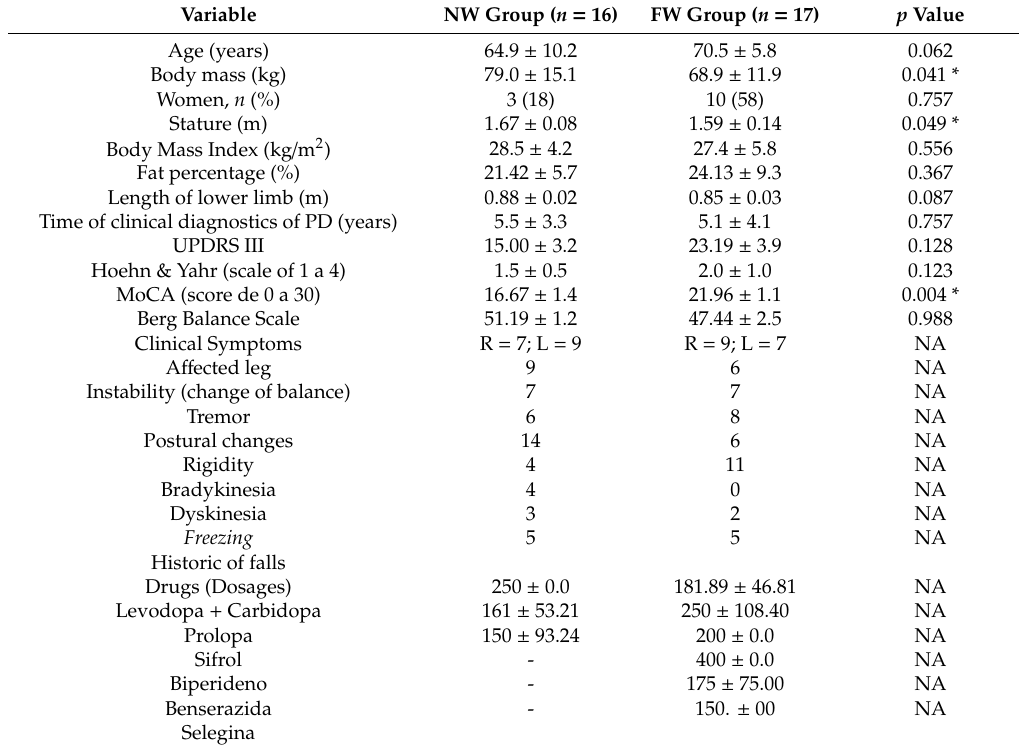
Table 1. Variables of sample characterization for the nordic and free walking groups in